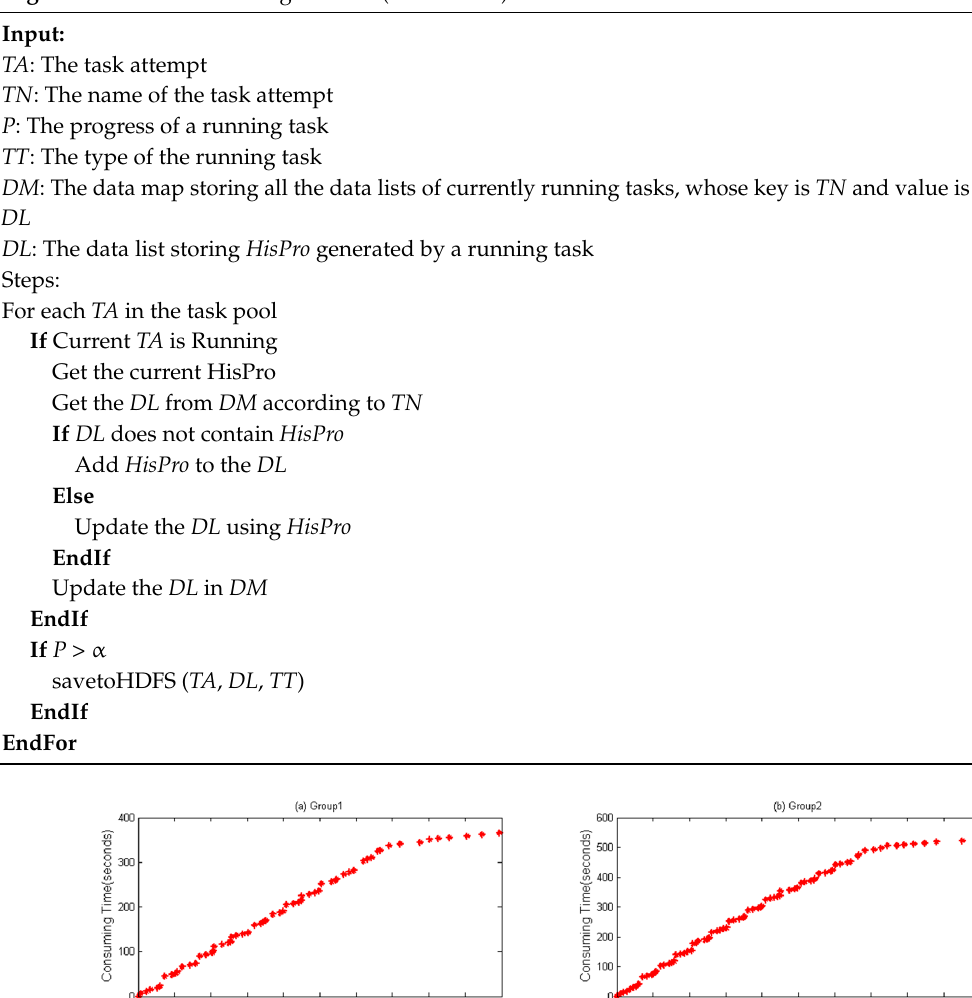
Algorithm 1: Data Collecting Method (GetDataSet)